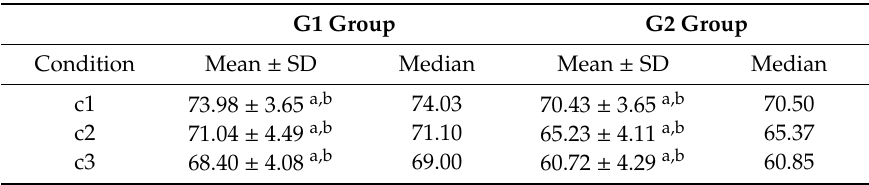
Table 5. Comparison of buccal BIC % values between the two groups under the three conditions at time 2 (3 months after implant